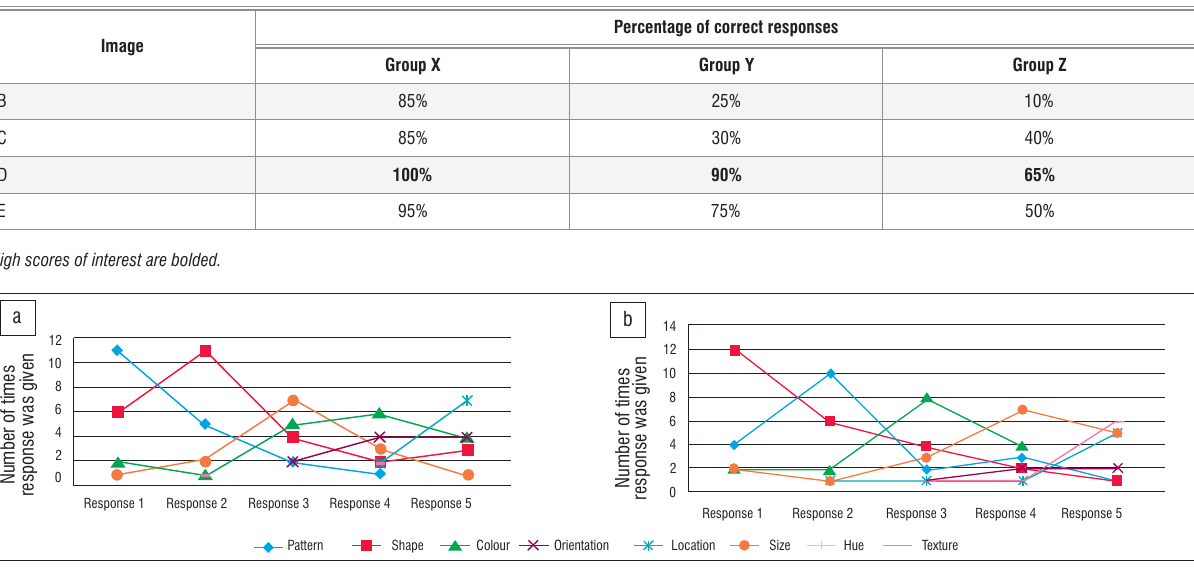
Figure 2: Responses from (a) Group X and (b) Group Y on image A, classified according to Bertin’s